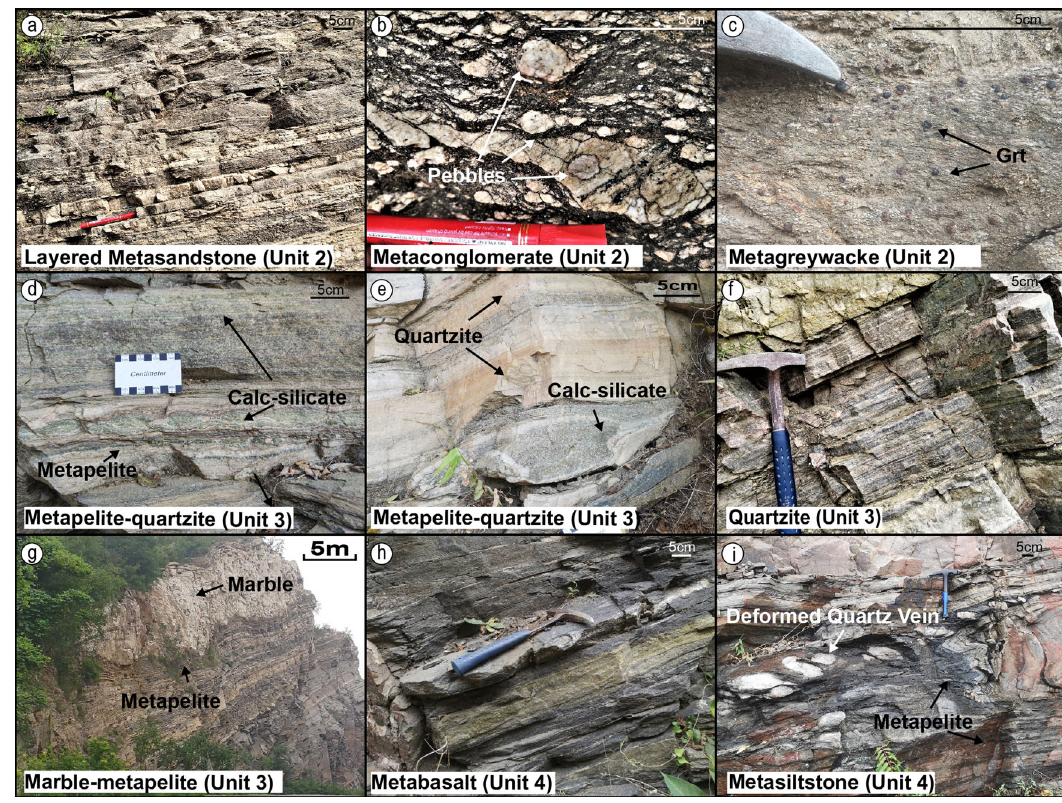
Fig. 5 | Field photos of autochthonous metasediments. a Sandstone with stable sedimentary banding. b Pebble conglomerate. c Greywacke with large garnet (Grt) porphyroblasts. d Interlayered metapelite and calc-silicate. e Interlayed quartzite andcalc-silicate. f Thinlylaminatedquartzite. g Thicklayerofmarbleandinterlayed